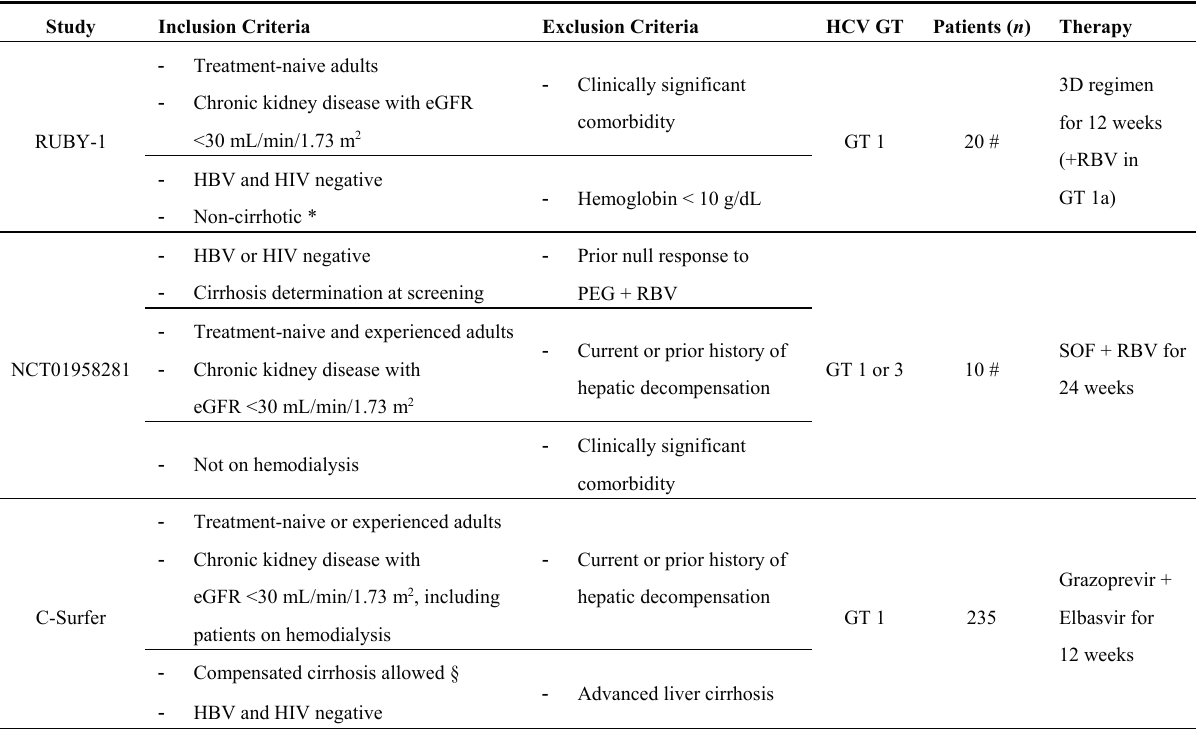
Table 3. Inclusion and exclusion criteria of revised clinical studies in patients with advanced renal